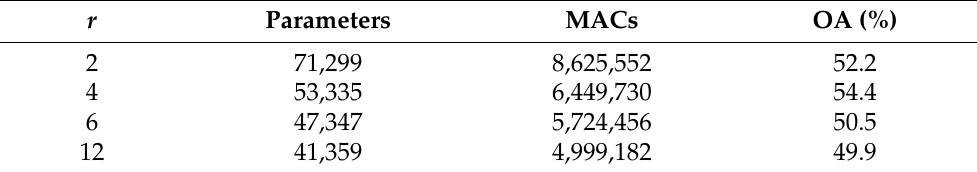
Table 7. Classification performance and the number of parameters and MACs of the proposed DRIN with different r values on the HyRANK dataset.